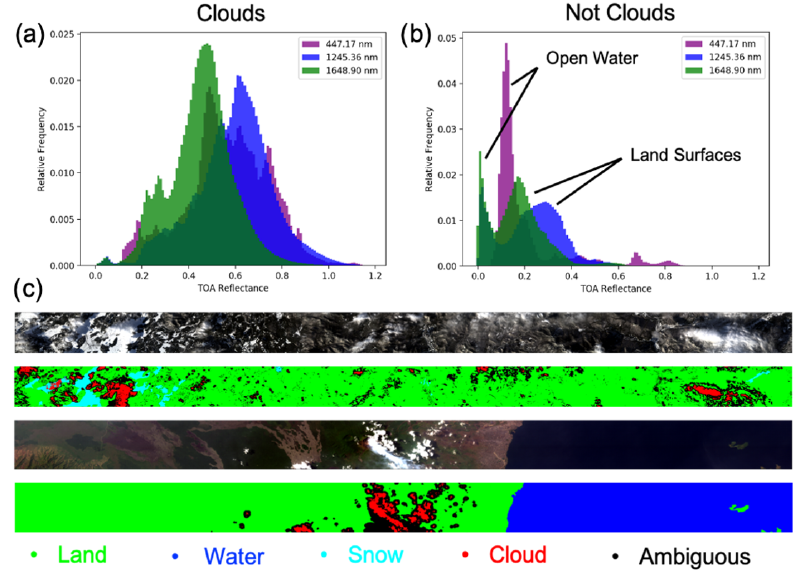
Figure 1. An example of the one-dimensional distributions of (a) cloudy and (b) non-cloudy pixels in each wavelength created from (c) the hand-labeled pixels in the Hyperion images used as ground truth.